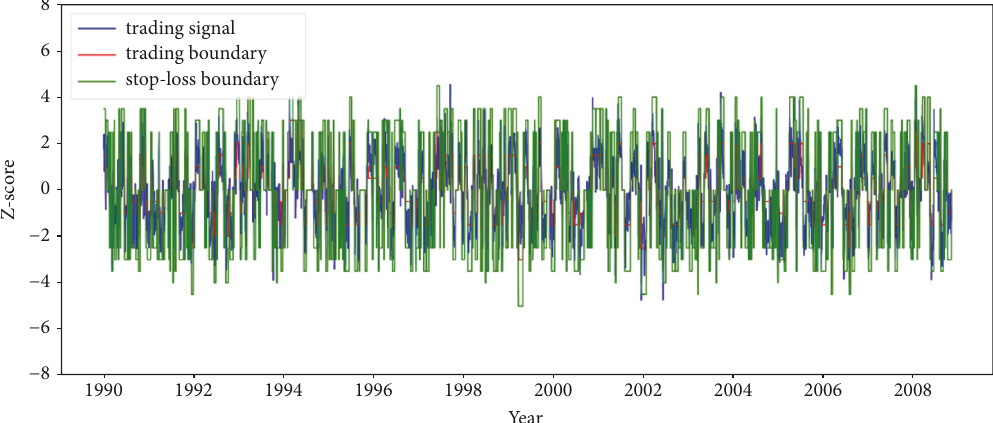
Figure 7: An example of optimizing PTDQN based on a training scheme using OLS.